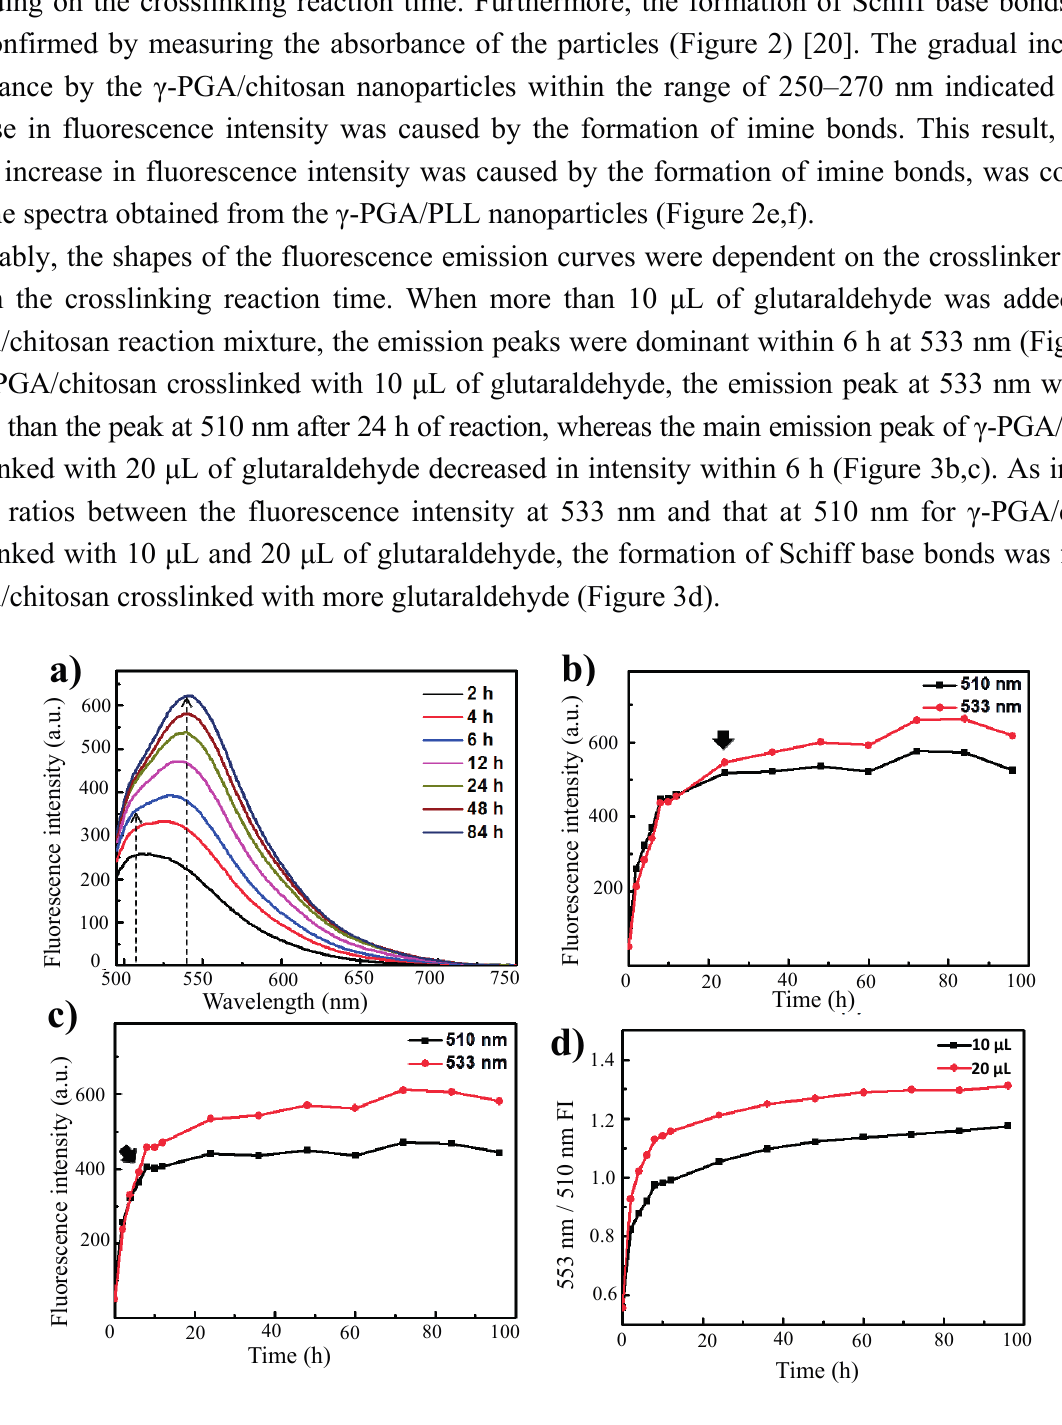
Figure 3. ( a ) Fluorescence emission spectra of γ -PGA/Chitosan cross-linked with 20 μ L glutaraldehyde for different times ( λ ex: 470 nm); The fluorescence intensity of ( b ) γ -PGA/Chitosan cross-linked with 10 μ L glutaraldehyde and ( c ) γ -PGA/Chitosan cross-linked with 20 μ L glutaraldehyde at 510 nm and 533 nm as a function of time; ( d ) Relationship between rates of formation of Schiff base, showed by calculating the ratio between fluorescence intensity at 533 nm and 510